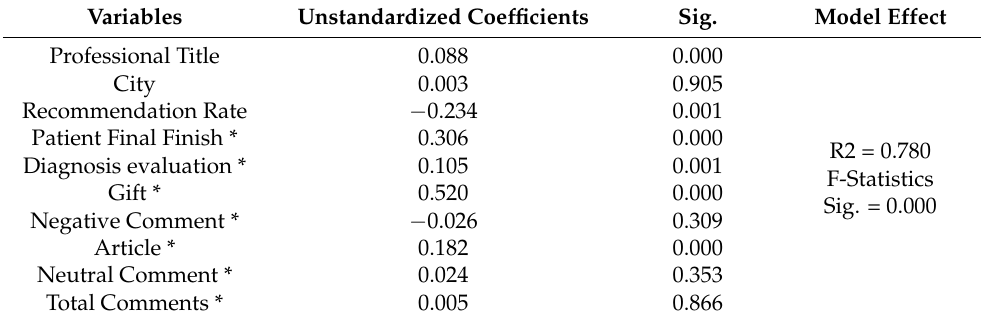
Table 3. Regression Coefficient (Group A).